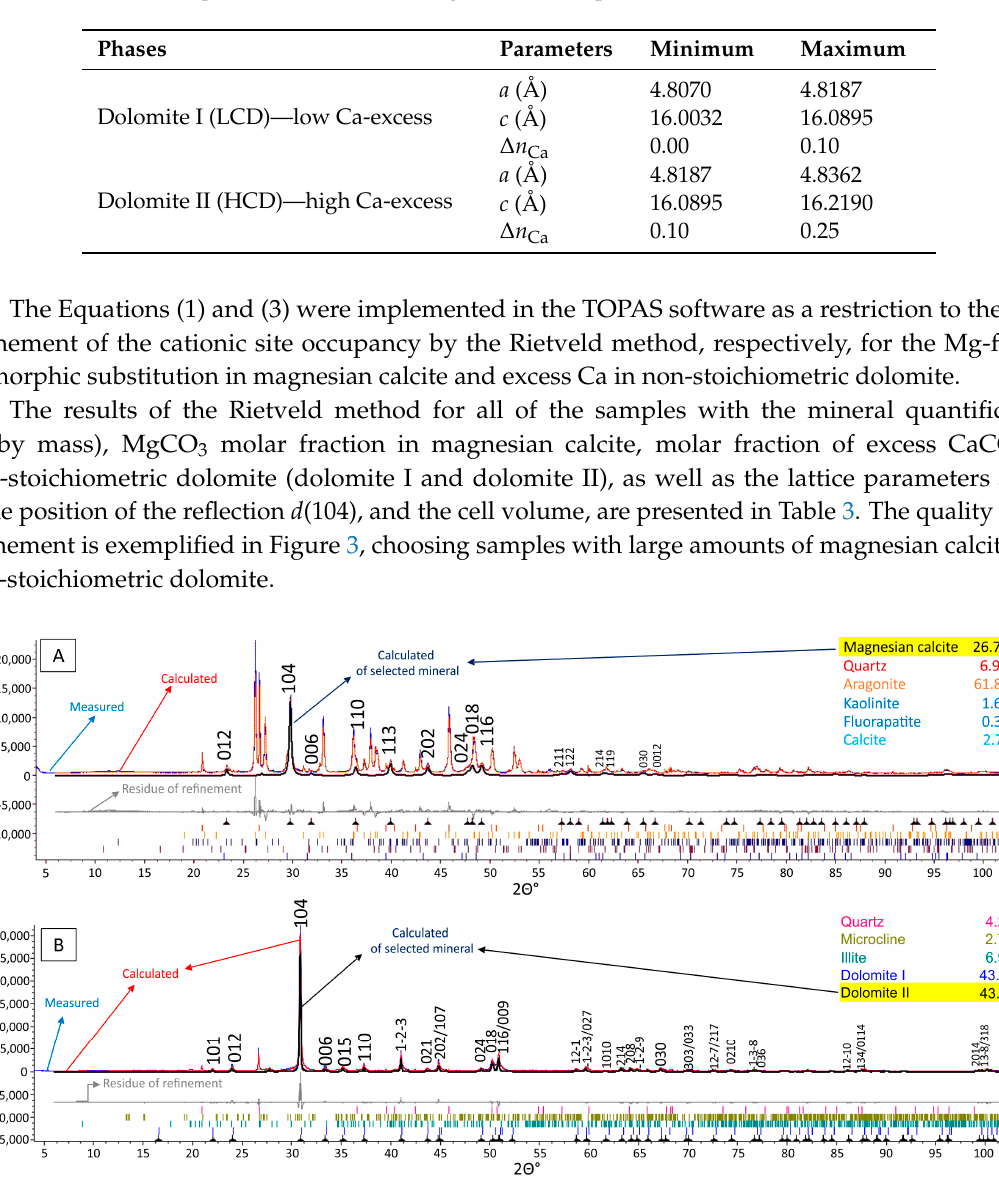
Table 2. Lattice parameters for dolomite generations implemented in the refinement software.